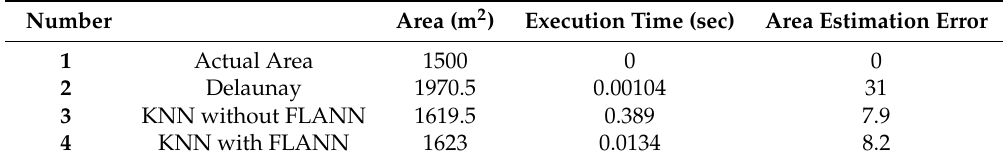
Table 4. Irregular Shape 2.